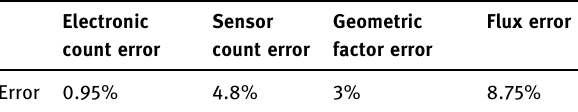
Sensor count error